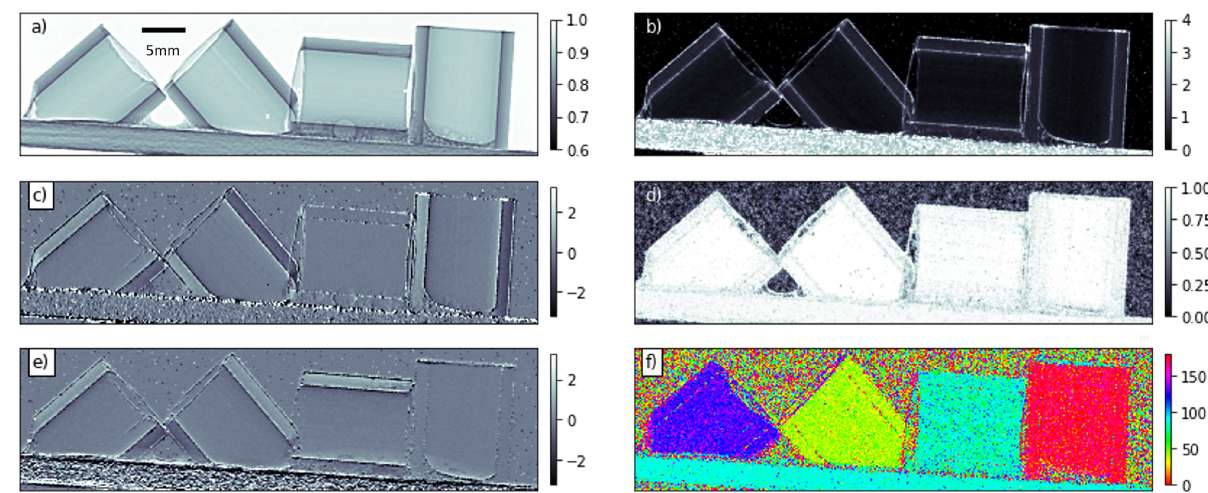
Fig 3. Results of the UMPA-DDF analysis for 25 diffuser positions and a 7 × 7 pixel window. a) Transmittance T . c) and e) Horizontal and vertical / d , u / d ) in μ rad. The right column shows the magnitude, directionality, and orientation of the extracted directional dark- refraction angles u / d = ( u x y field signal: b) Average kernel width σ , in pixels. d) Directionality, given by the eccentricity ε of the kernel’s exponential argument. f) Orientation θ of the larger scattering axis relative to the horizontal, given in degrees.